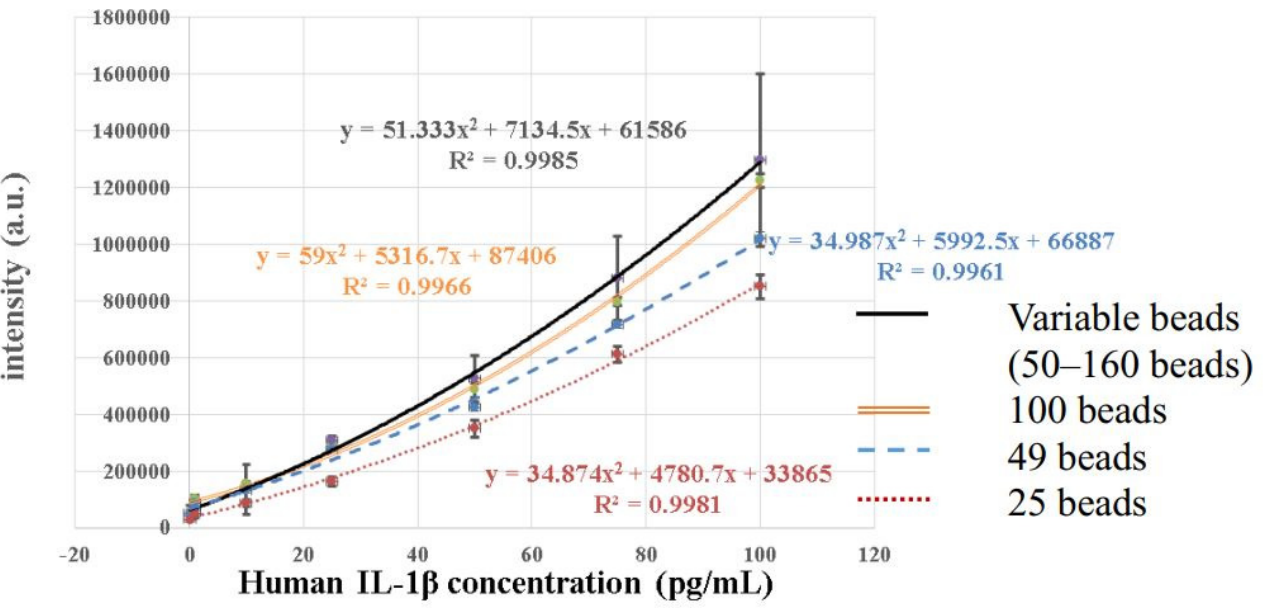
Figure 4. Comparison of the calibration curves obtained by an unfixed number of magnetic beads (50–160) and three fixed numbers of magnetic beads (100, 49, and 25).